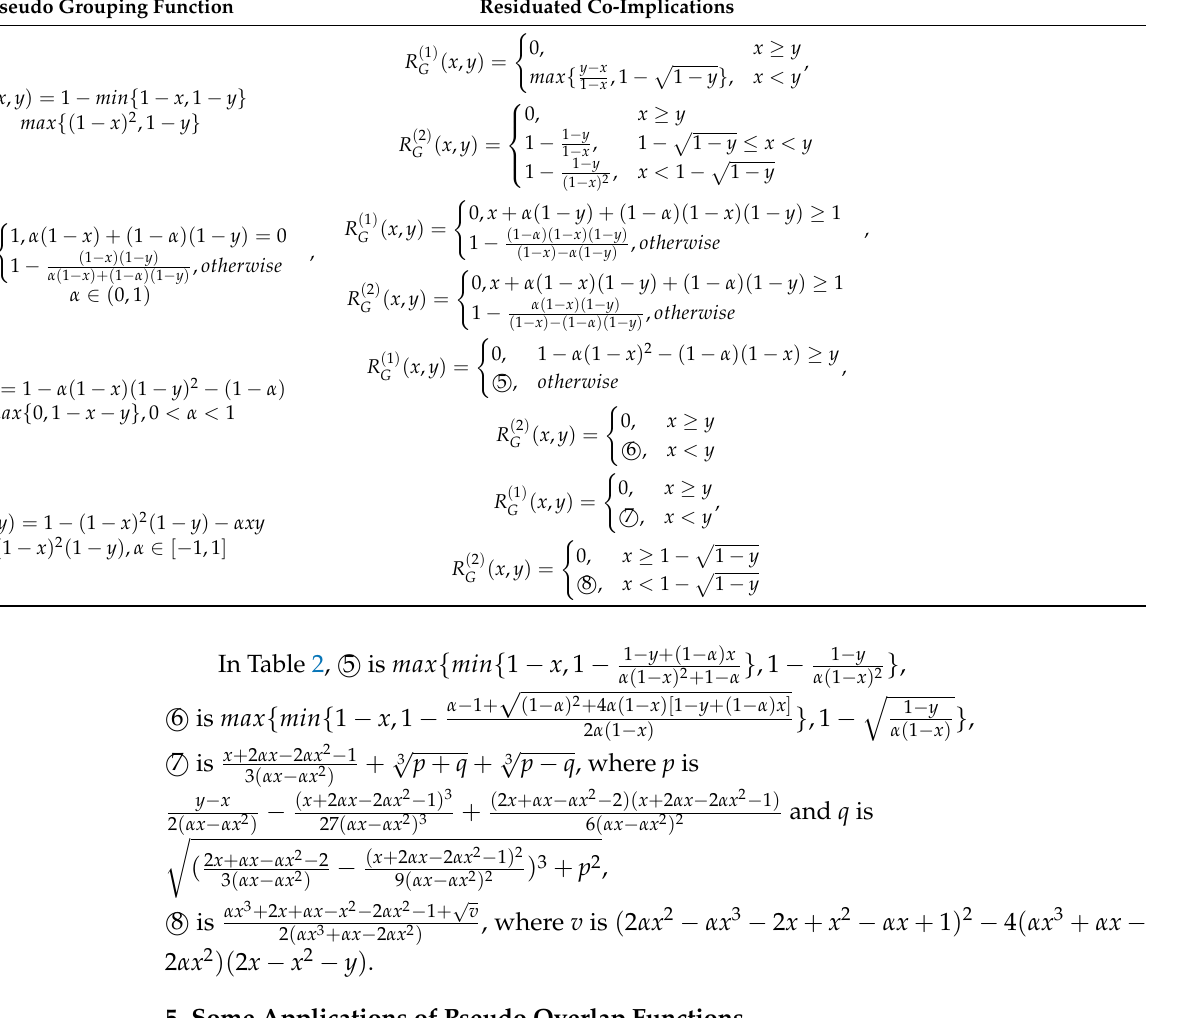
Table 2. Cont. Pseudo Grouping